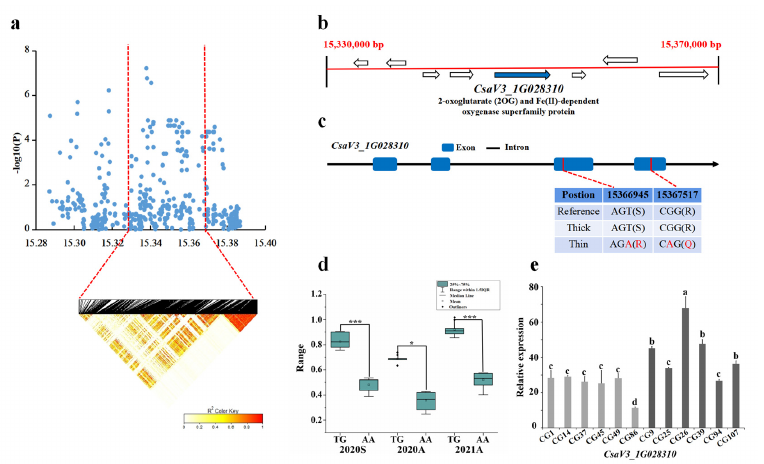
Figure 4. Identification of the stem diameter-related gene at locus gSD1.1 . ( a ) Manhattan map of near 100 kb ( top ) and LD heatmap ( bottom ) surrounding the peak of gSD1.1 . ( b ) Eight genes predicted in the LD block region. Blue represents the genes that are different. ( c ) SNP variation of the candidate gene CsaV3_1G028310 among thick and thin stem lines (Table S6). Two SNPs (in red) were located in CDS, resulting in amino acid changes. ( d ) Haplotype difference of CsaV3_1G028310 . *** indicatess significance p < 0.001. ** indicatess significance p < 0.01. * indicatess significance p < 0.05. ( e ) Relative expression analysis of CsaV3_1G028310 . Gray column represents the thin stem samples (CG1, CG14, CG37, CG45, CG49, CG86); Black column represents thick stem samples (CG9, CG25, CG26, CG39, CG94, CG107). a,b,c and d represent the level of significant difference from high to